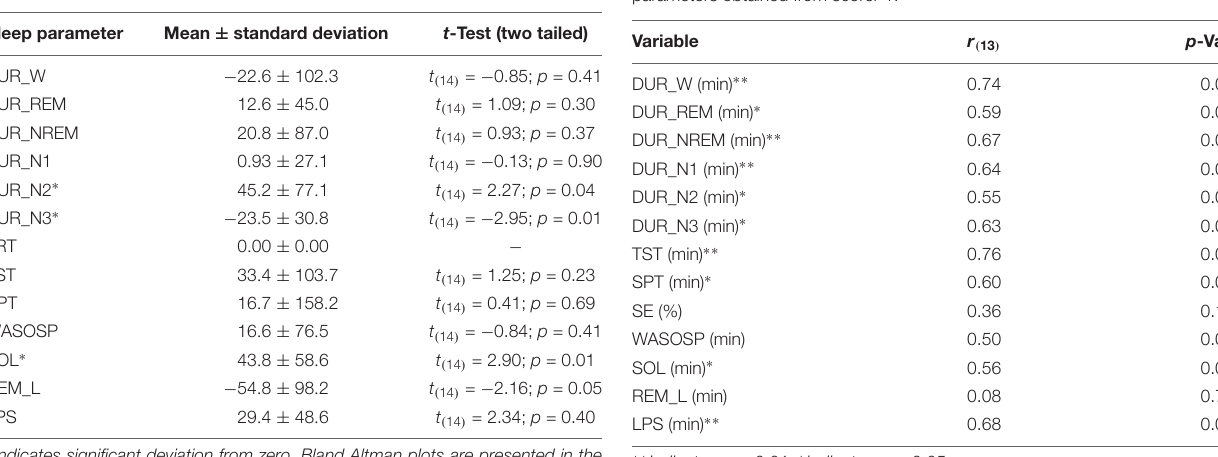
TABLE 5 | Epoch-to-epoch concordance (%) for manual scoring.